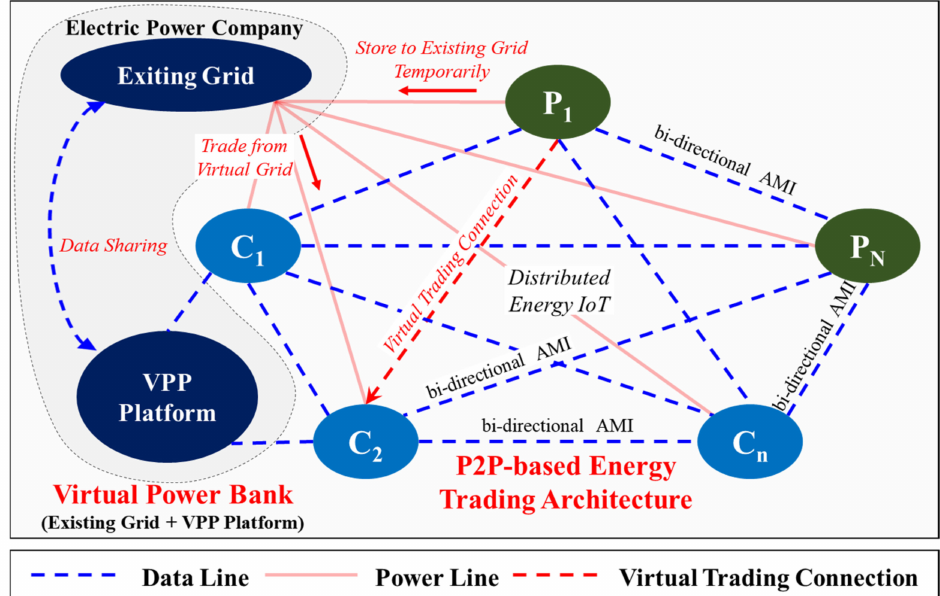
Figure 5. P2P-based proposed system